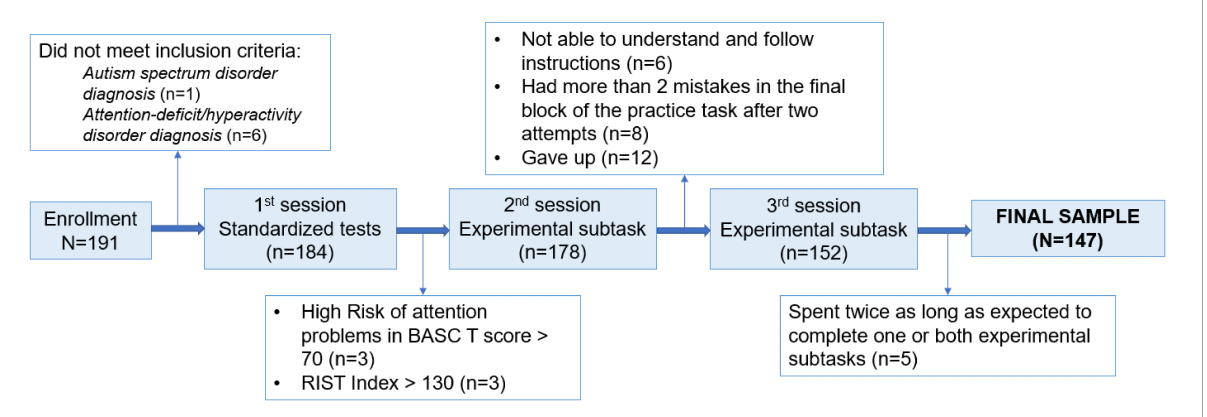
FIGURE2 Flow of participants in each stage of the study. CPT, Conners Continuous Performance Test; K-CPT, Conners Kiddie Continuous Performance Test; and BASC, Parent Report form of The Behavioral Assessment Scale for